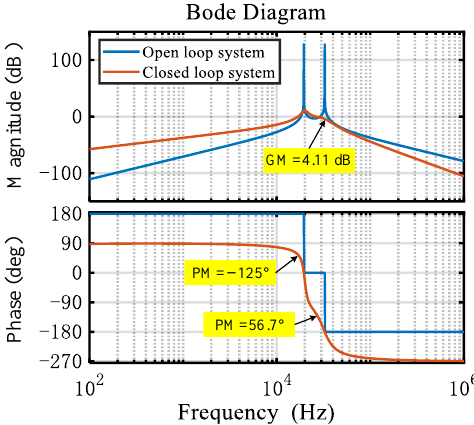
Figure 12. Bode diagram of LCLC resonant inverter.